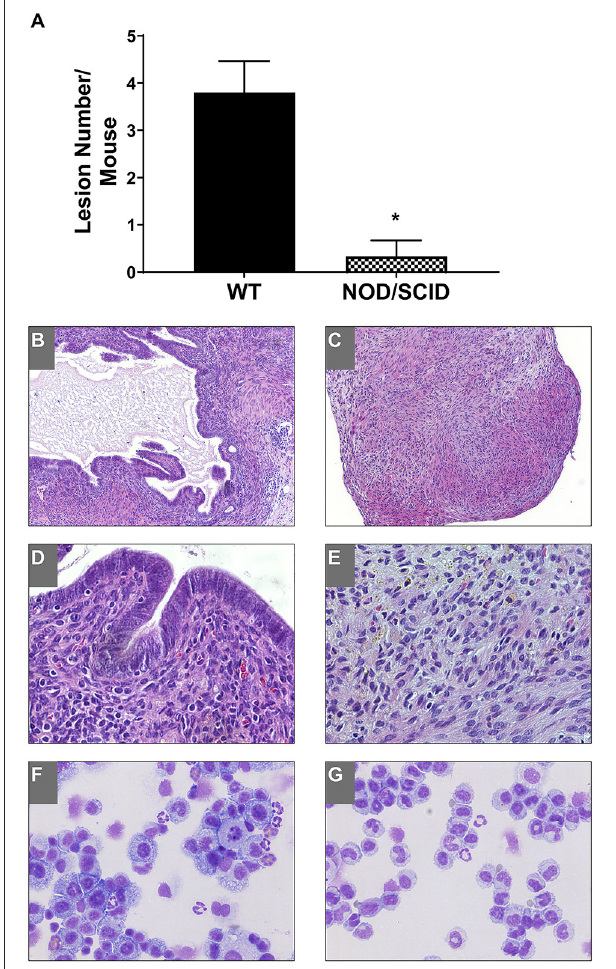
FIGURE 1 | NOD/SCID to NOD/SCID transfers do not form endometriotic lesions and have decreased immune cells involved in the peritoneal cavity. (A) Endometriotic lesion numbers found in WT to WT and NOD/SCID to NOD/SCID uterine endometrial tissue transfer. (B–E) Histological evaluation (H&E) of lesion tissue. (B,D) WT to WT lesions. (C,E) NOD/SCID to NOD/SCID lesions. (F,G) Peritoneal lavage differentials. Magnification: 10 × : (B,C) and 40 × : (D,E) . * p < 0.05, one-tailed, unpaired t -test, Welsh’s correction. WT, wild